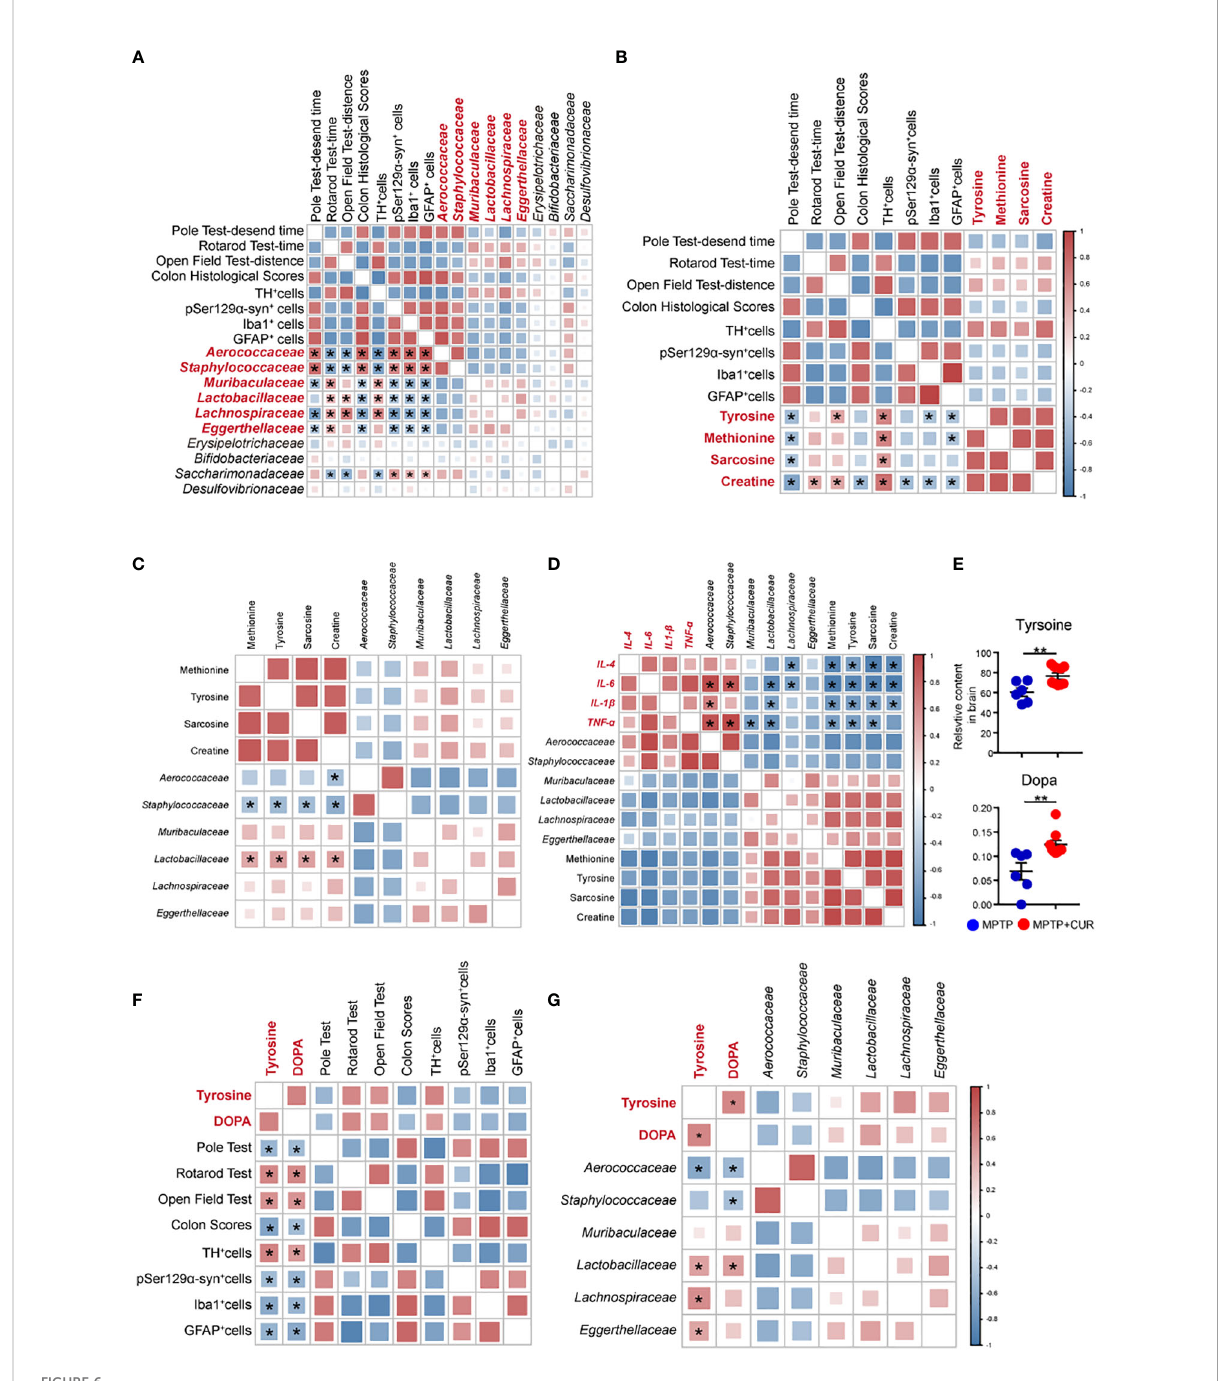
FIGURE 6 Correlations between changes in gut microbiota pro fi le, serum metabolism alterations and PD-related pathological results. (A) Heatmap of Pearson ’ s correlation coef fi cients between the abundances of top 10 taxa at family level and PD associated results. Bacterial groups in red represent the top 6 altered taxa. (B) Heatmap of Pearson ’ s correlation coef fi cients between the levels of differentially-altered serum metabolites and PD associated results. (C) Heatmap of Pearson ’ s correlation coef fi cients between the abundances of 6 altered bacteria and PD associated results. (D) Heatmap of Pearson ’ s correlation coef fi cients between the expression of differentially-altered in fl ammatory cytokines and levels of pivotal gut bacteria and metabolites. (E) The relative contents of tyrosine and dopa in the brain. (F) Heat map of Pearson ’ s correlation coef fi cients between the brain levels of tyrosine and dopa and PD associated results. (G) Heat map of Pearson ’ s correlation coef fi cients between the tyrosine and dopa levels of brain and the key altered gut microbiota taxa. Data are expressed as mean ± SEM. Statistical differences were tested using Pearson ’ s correlation analysis. * p < 0.05; **p<